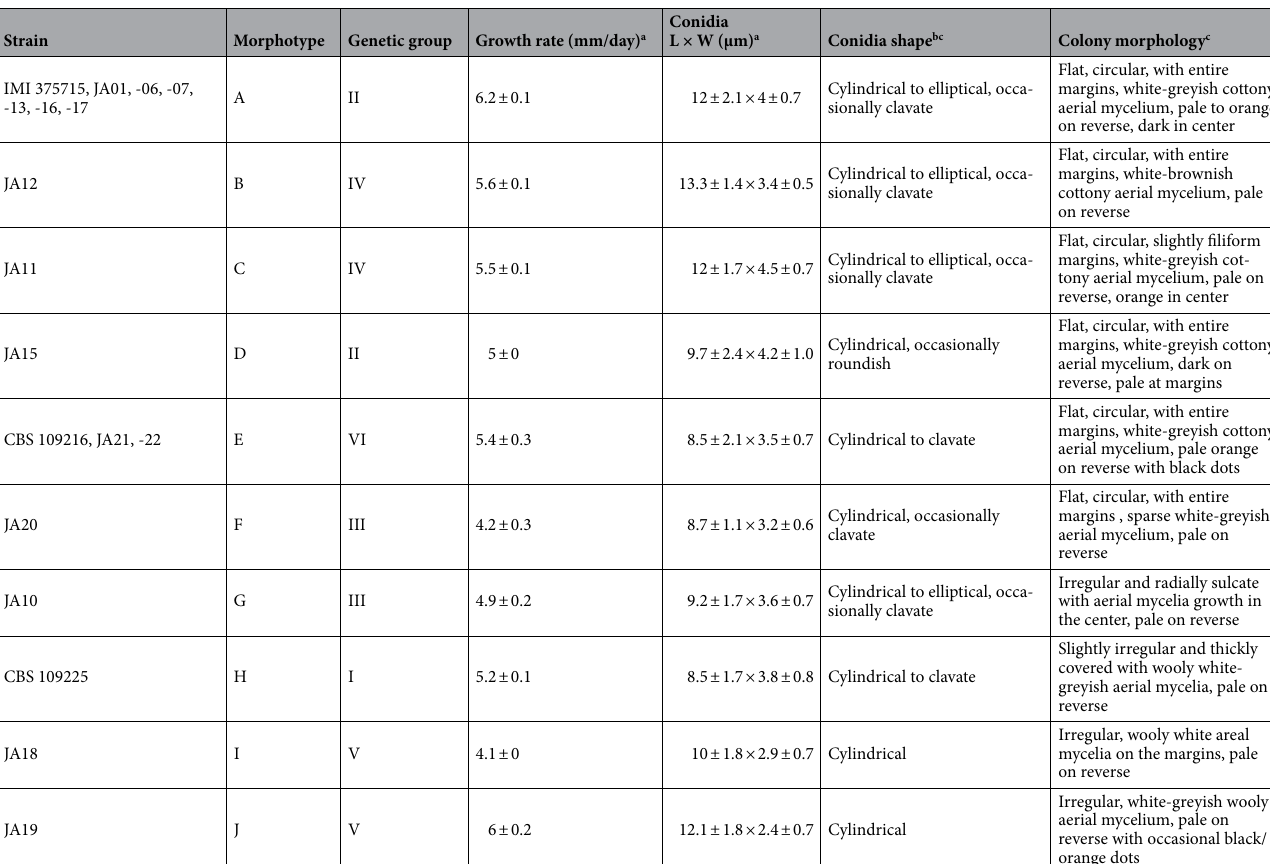
Table 2. Growth rate, conidial size and shape, and colony morphology for the different morphotypes observed within Colletotrichum lupini . L length, W width. a Mean ± SD, see also Supplementary Fig. S2. b Observed conidia were rather variable in shape and size, but all conidia were hyaline, smooth-walled, aseptate, straight, with one end round and one end acute as described for Colletotrichum lupini in Damm et al . 14 . c See also Fig.